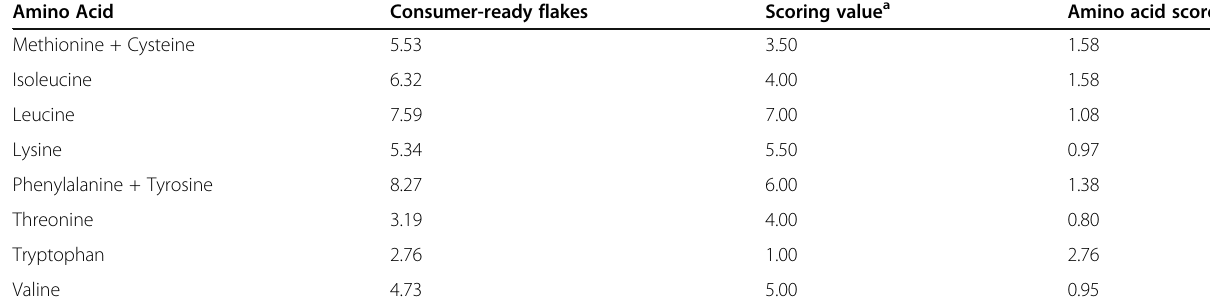
Table 7 Amino acids scores with reference to FAO provision amino acid scoring pattern (g/100 g) Amino Acid Consumer-ready